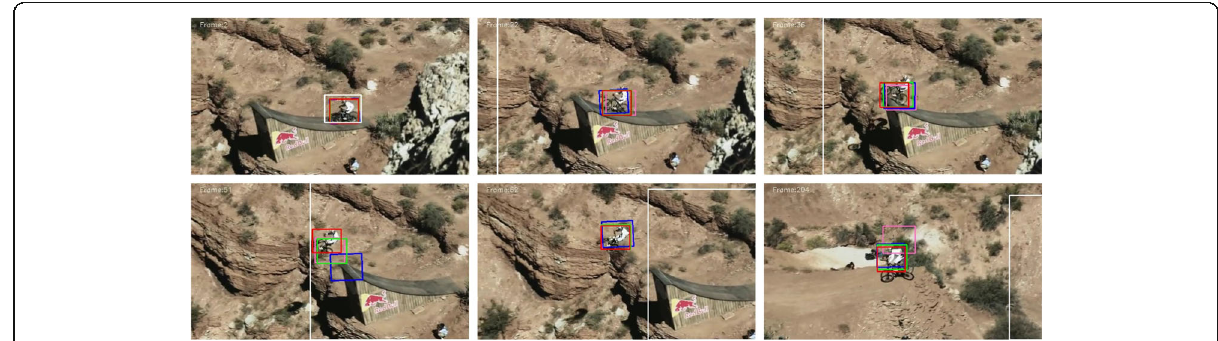
Fig. 20 The tracking results for the video “ MountainBike ” using CAM-Shift (white), PF (blue), VAPF (green), M-PF (pink), and the proposed tracker (red). Particle number N =